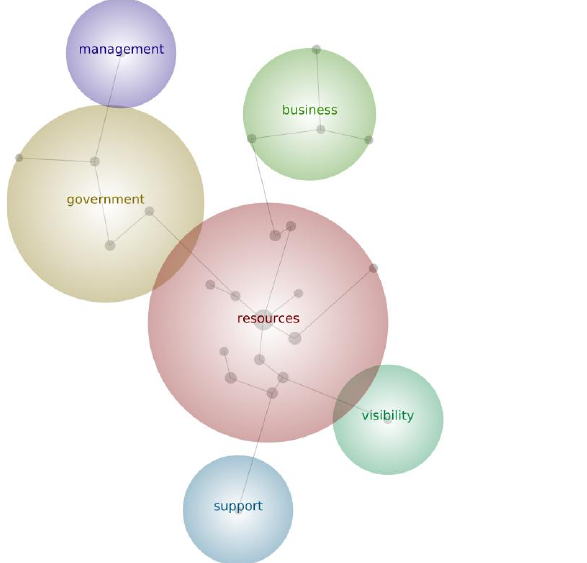
Figure 2: Enablers